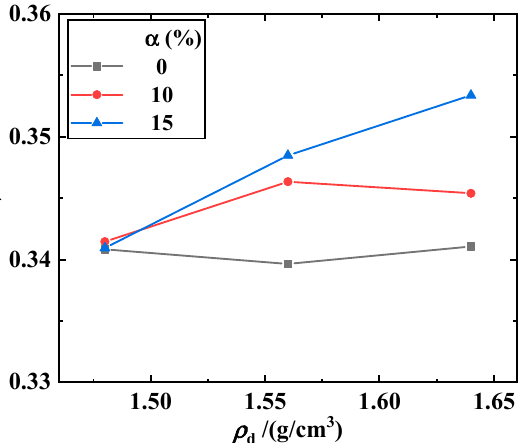
Figure 7. Relationship between Poisson’s ratio and dry density of the biochar–clay mixture.